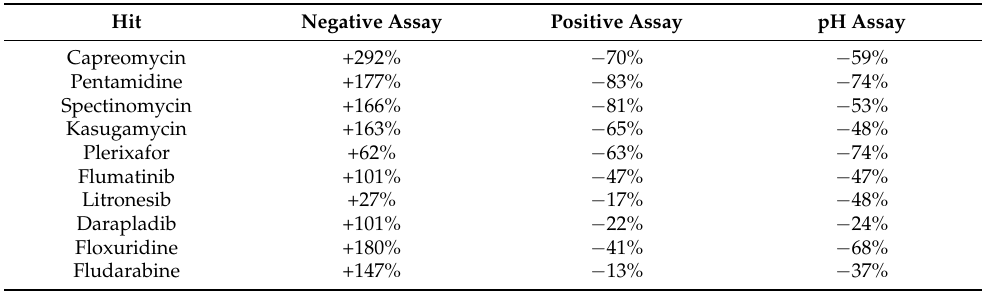
Figure 4. Compound screening results using the negative and positive assays. ( a ). Negative assay in which SARS-CoV-2 3a protein is expressed at an elevated level (induction with 100 µ M β - D -1-thiogalactopyranoside) and is therefore deleterious to DH10B bacteria. In this instance, inhibitory drugs enhance bacterial growth. ( b ). Positive assay in which SARS-CoV-2 3a protein is expressed at a low level (12.5 µ M β - D -1-thiogalactopyranoside) in K + -uptake deficient bacteria (LB650). In this instance, inhibitory drugs reduce bacterial growth. The results in both panels may be compared to those obtained without any drug (gray) or when the channel is uninduced (black). The color scale indicates the different concentrations of the chemicals, which were performed in duplicates. Table 1. Impact of drugs in the different assays. In the negative and positive assays, the values represent the growth enhancement or retardation relative to untreated bacteria, respectively. In the pH assay, the values represent the reduction in H + concentration change relative to untreated bacteria. All compounds were assessed at 50 µ M